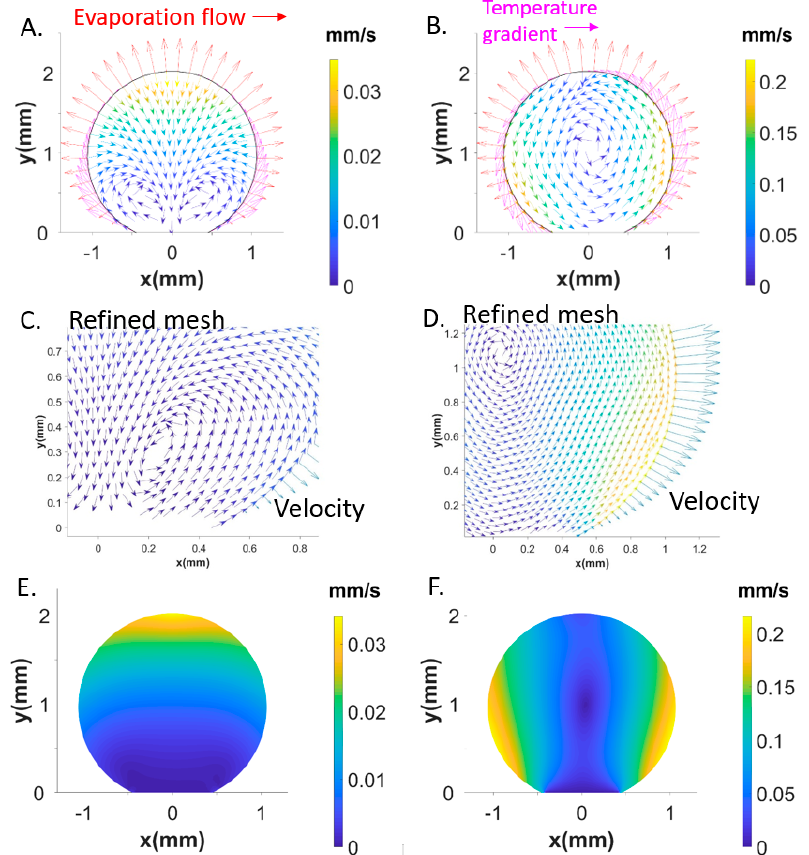
Figure 6. Recirculating flows in the two hemispheres of the droplet revealed by flow vectors. Evaporation flux vectors normal to rim. Tangential stress vectors in pink ( A ). Central recirculating flow ( B ). Recirculating flows in one hemisphere and central recirculating flow shown with a refined mesh ( C, D ). Heat map of magnitude of flow vectors for recirculating flow in two hemispheres ( E ). Heat map of magnitude of flow vectors central recirculating flows ( F ).